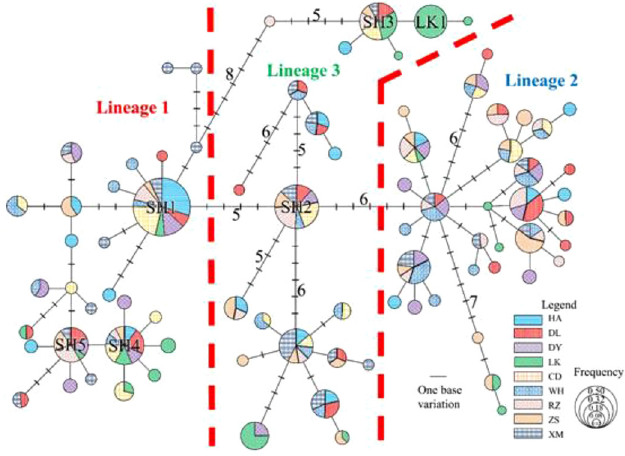
Fig. 3. Haplotype median-joining network of T. modestus .